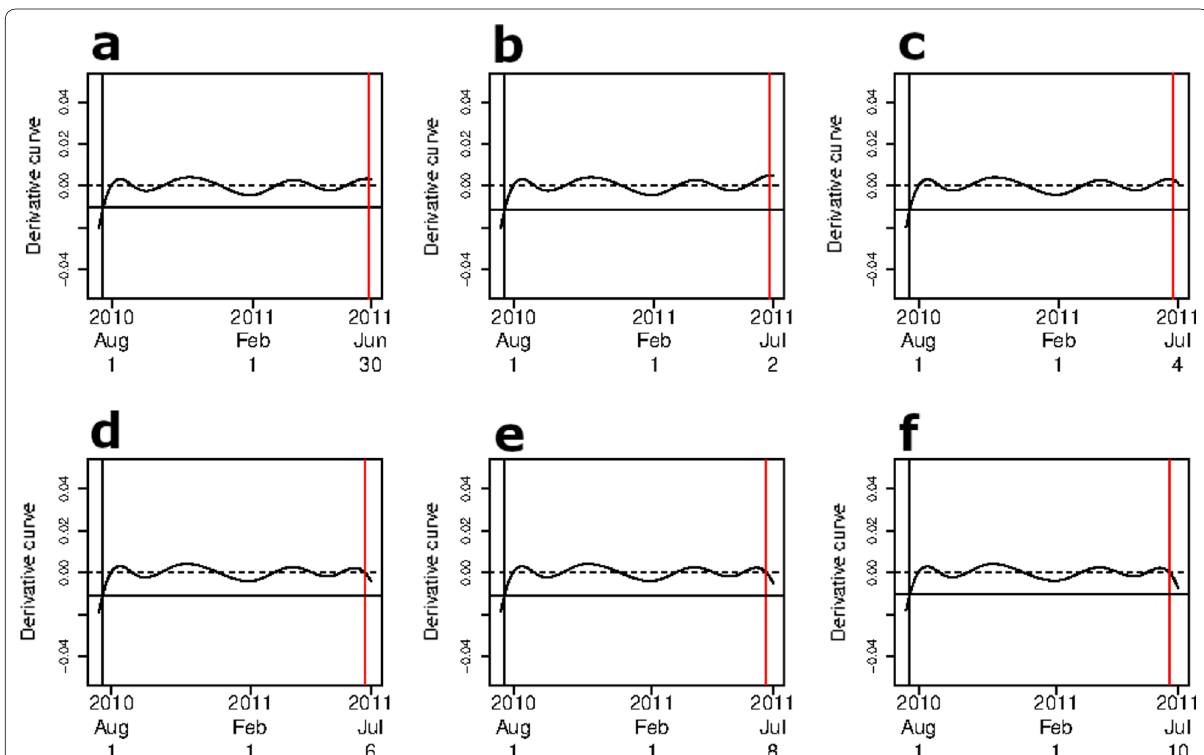
Fig. 11 Derivative curves of the displacement curves in the p‑splines basis by considering data series up to 2, 4, 6, 8 10 and 12 days after Jun 28, 2011. The black vertical line indicates the beginning of the timeseries data used to calculate the minimun slope level. When calculating the level, the first 30 data are not considered for the oscillations that occur at the beginning of the b‑splines curves. The red vertical line marks the 28 Jun